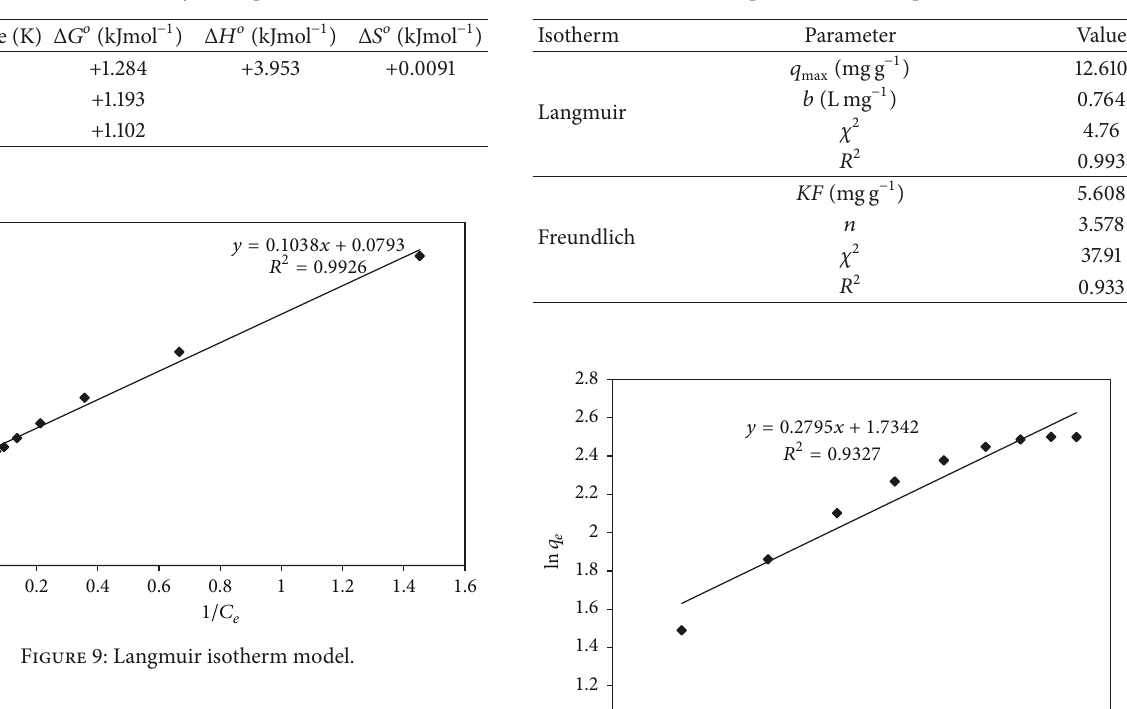
Table 6: Equilibrium studies parameters.